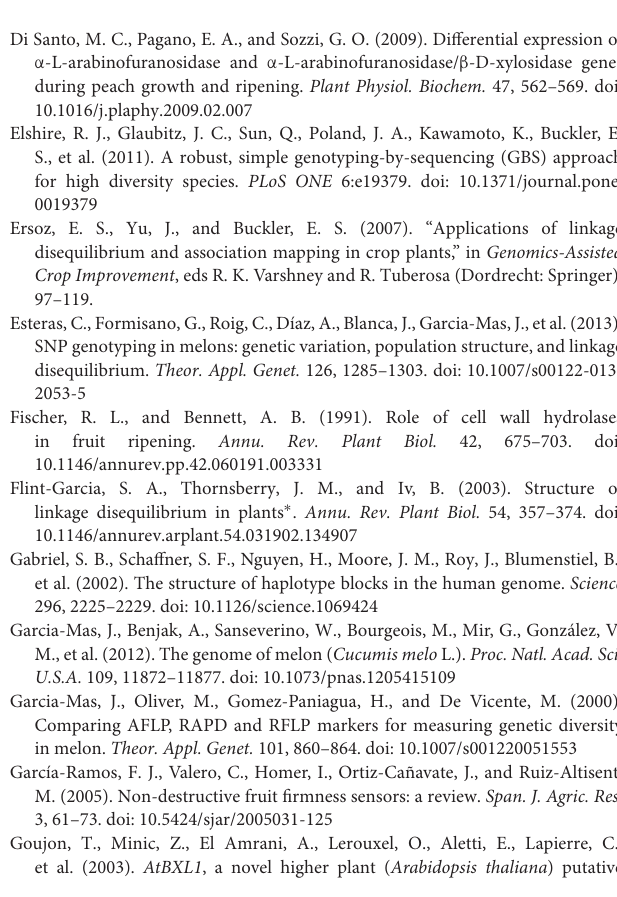
Table S5 | Haplotype blocks across entire melon collection in the